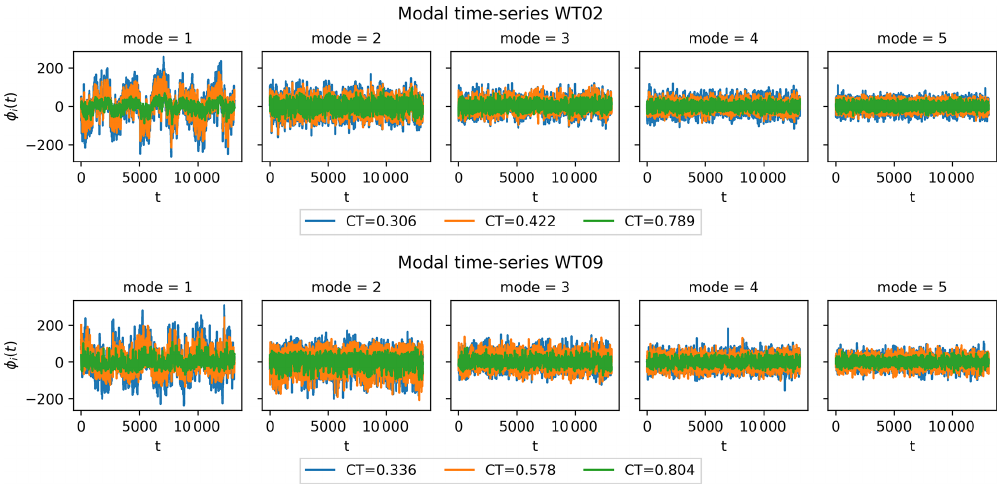
Figure 6. Modal time series of the first five global POD modes for WT02 and